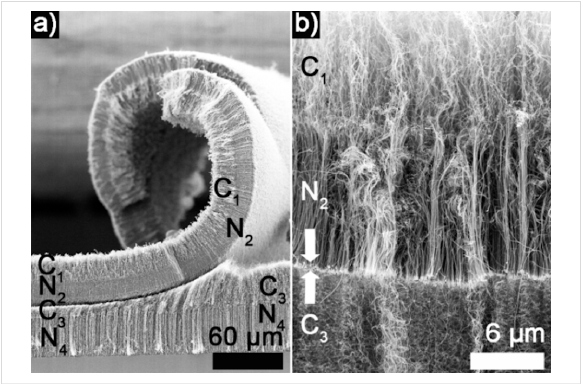
Figure 1: (a) SEM micrograph of a C 1 /N 2 /C 3 /N 4 structure in which a break between the N 2 and C 3 part leads to MWCNTs layers to peel off. (b) SEM micrograph of C 1 /N 2 /C 3 structures in which the N 2 /C 3 inter- face displays iron-based particles. The bright line between the